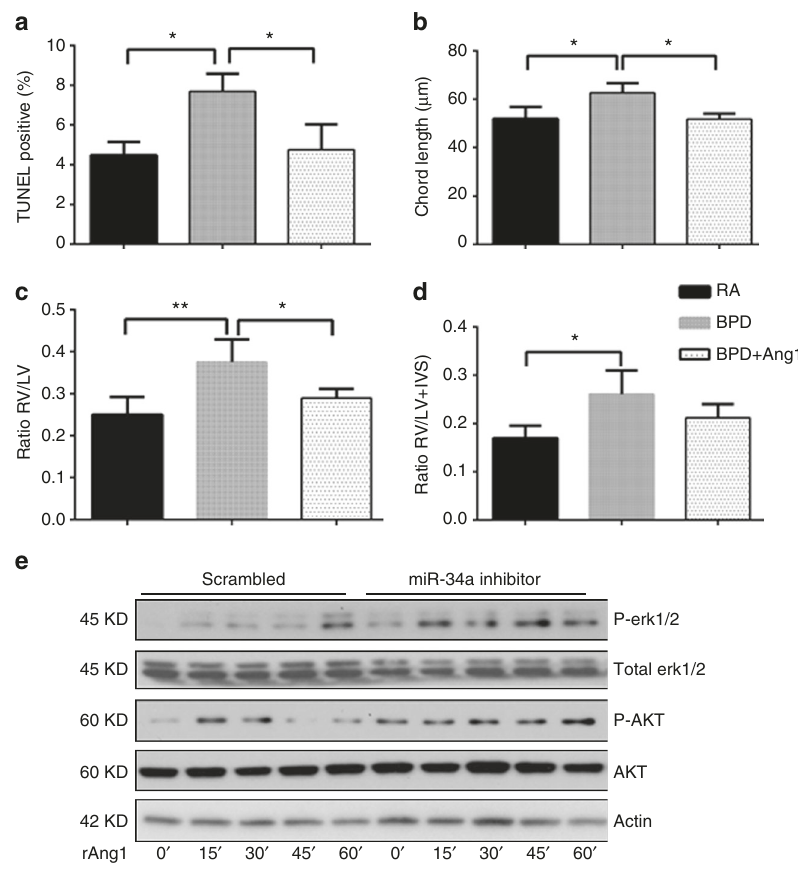
Fig. 9 Improved effects of miR-34a inhibition occurs via Ang1-Tie2 signaling. a , b Representative bar graphs show improved TUNEL and morphometry in recombinant Ang1 (rAng1) treated mouse lungs. c , d Improved RV to LV and RV/(LV + IVS) ratios were noted in rAng1 treated BPD mice as compared to controls. e Activation of Erk and Akt signalling by rAng1 in miR-34a inhibitor or scrambled control transfected MLE12 cells as analyzed by western blot of phosho-Erk1/2, total Erk1/2 protein, phospho-Akt and total Akt protein, shown at the indicated time points. Ang1: angiopoietin 1; RV: right ventricle; LV: left ventricle; IVS: interventricular septum. Values are means ± SEM of a minimum of four observations (in vitro experiments) or four animals (in vivo experiments) in each group. * P < 0.05, ** P < 0.01, compared with controls, 1-way